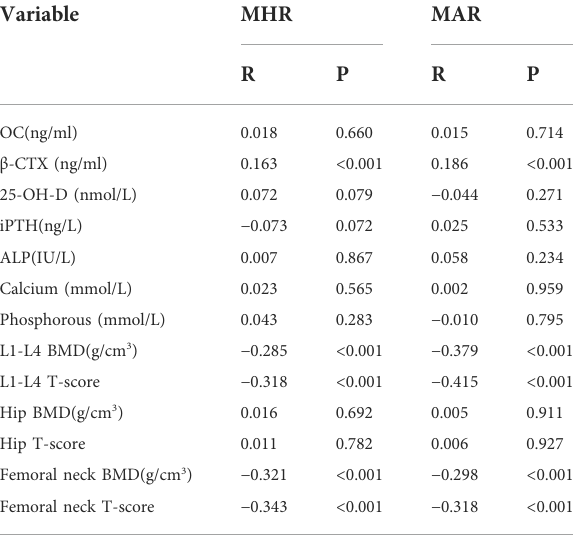
TABLE3CorrelationsbetweenMHR,MARandboneturnovermarkers, bone mineral density.